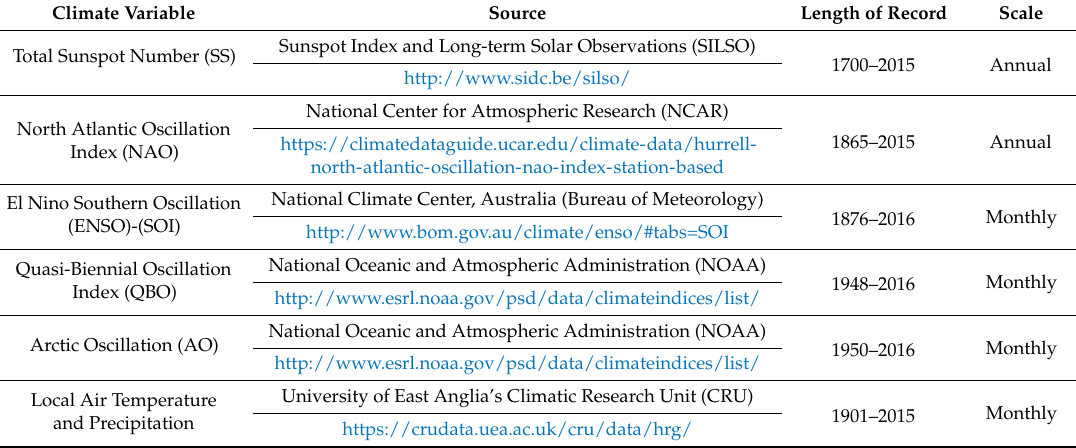
Table 2. Large-scale climate oscillations and local weather data used to identify drivers of lake ice